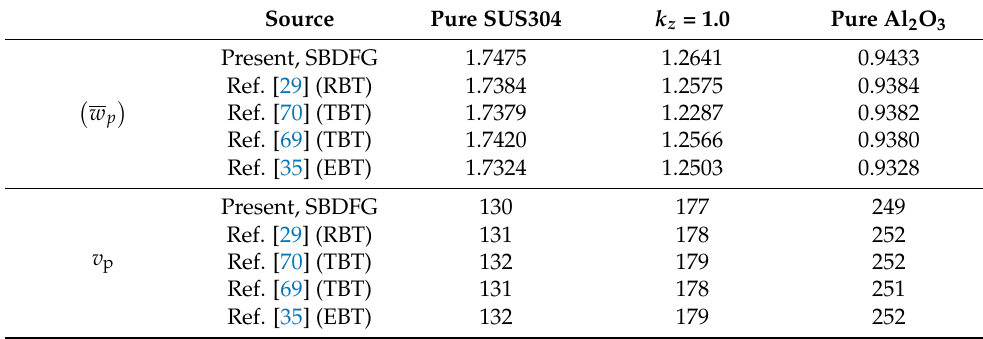
Table 1. Peak normalized dynamic deflection supported beams, at T (z) = 0.